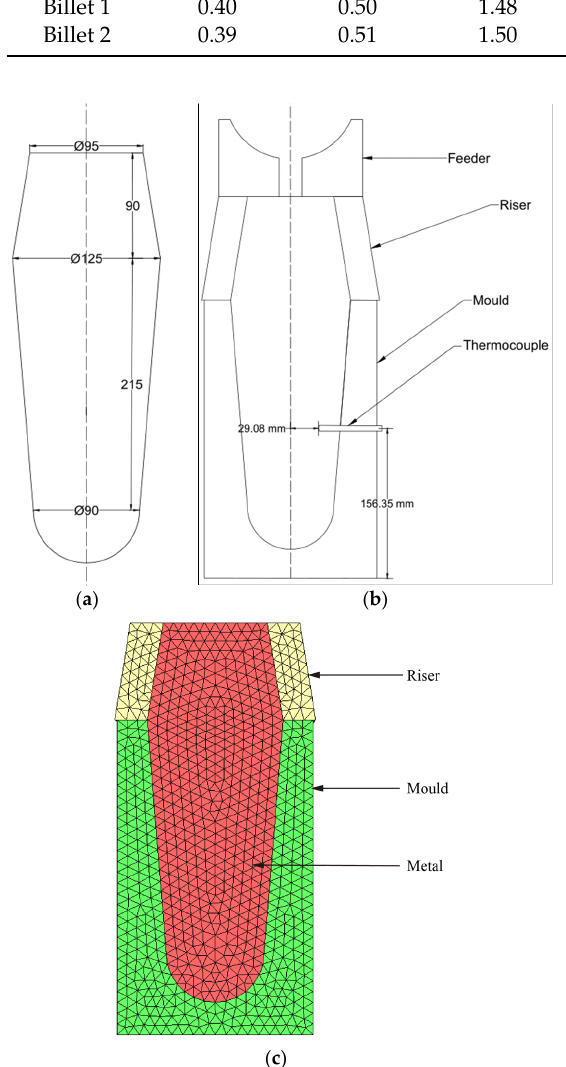
Figure 1. Schematic of the casting experiment: ( a ) dimensions of the billet (mm); ( b ) setup for measuring temperature; ( c ) finite element model of heat transfer.